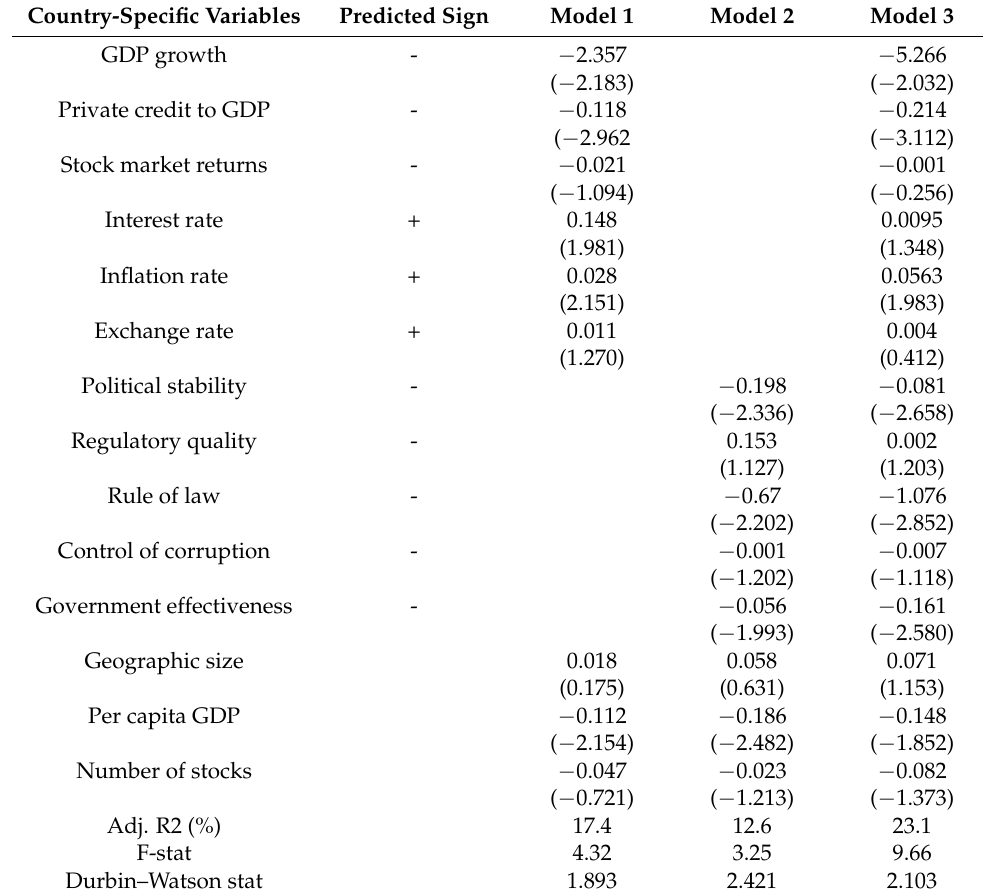
Table 5. Coefficient estimates of country-level determinants of liquidity